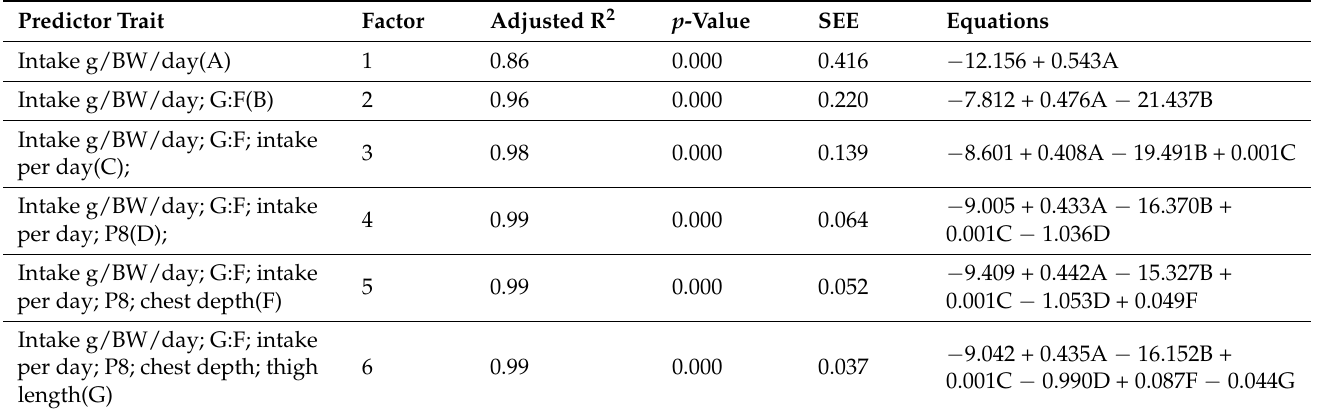
Table 6. Linear regression fitting statistics for RFI. RFI: residual feed intake; G:F: feed conversion ratio; P8: rump fat thickness; SEE: standard error of